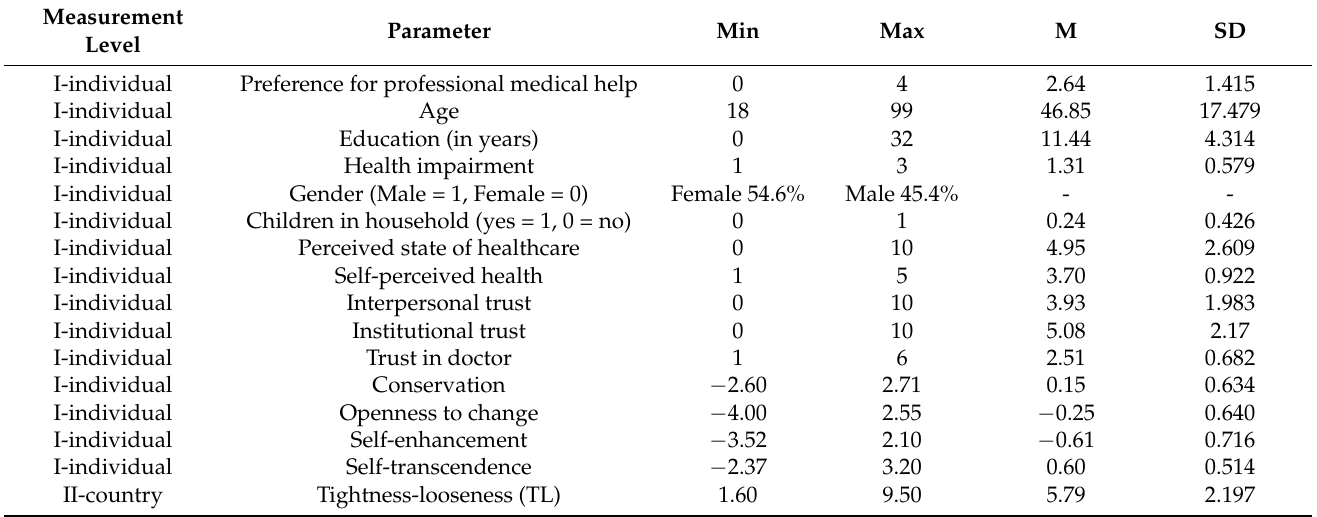
Table 1. Descriptive statistics for main